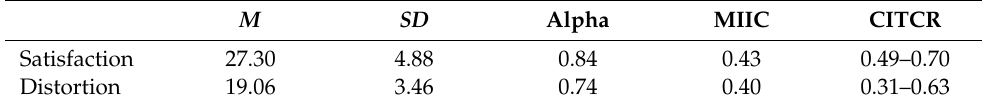
Table 4. Internal consistencies of the EMS.